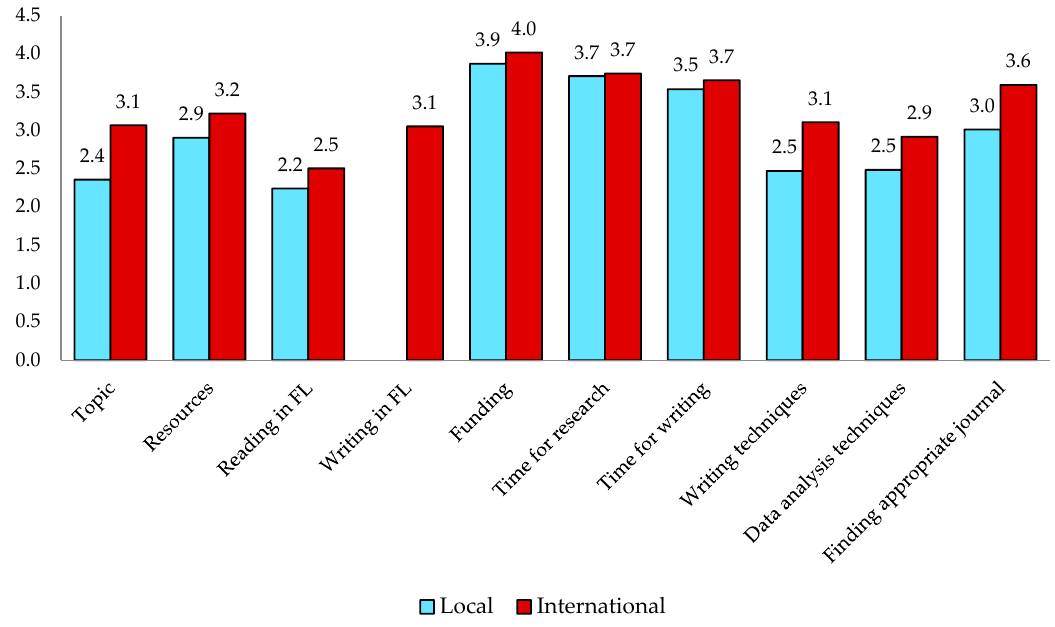
Figure 4. Obstacles to local and international publication.